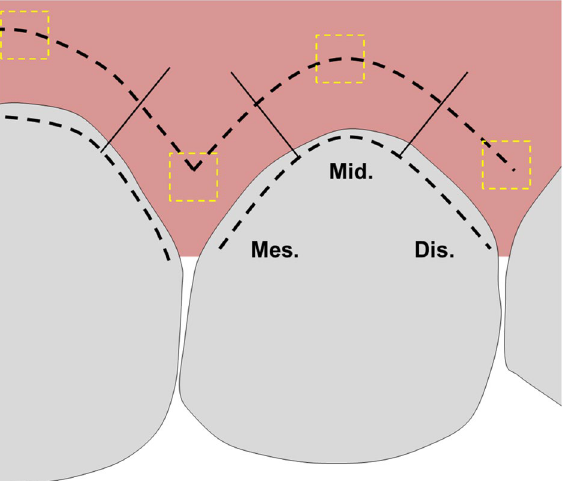
Figure 1. Cartoon showing the MGI scoring and Hy-SFDI data collection sites. The black dashed line shows the location of MGI scoring and the solid black line shows the division of the mesial, middle, and distal sections of the tooth. MGI was scored separately for each of the tooth sections. The yellow dashed boxes show the approximate locations where the Hy-SFDI data was collected. A total of 14 Hy-SFDI were collected (7 from the upper incisors and 7 from the lower